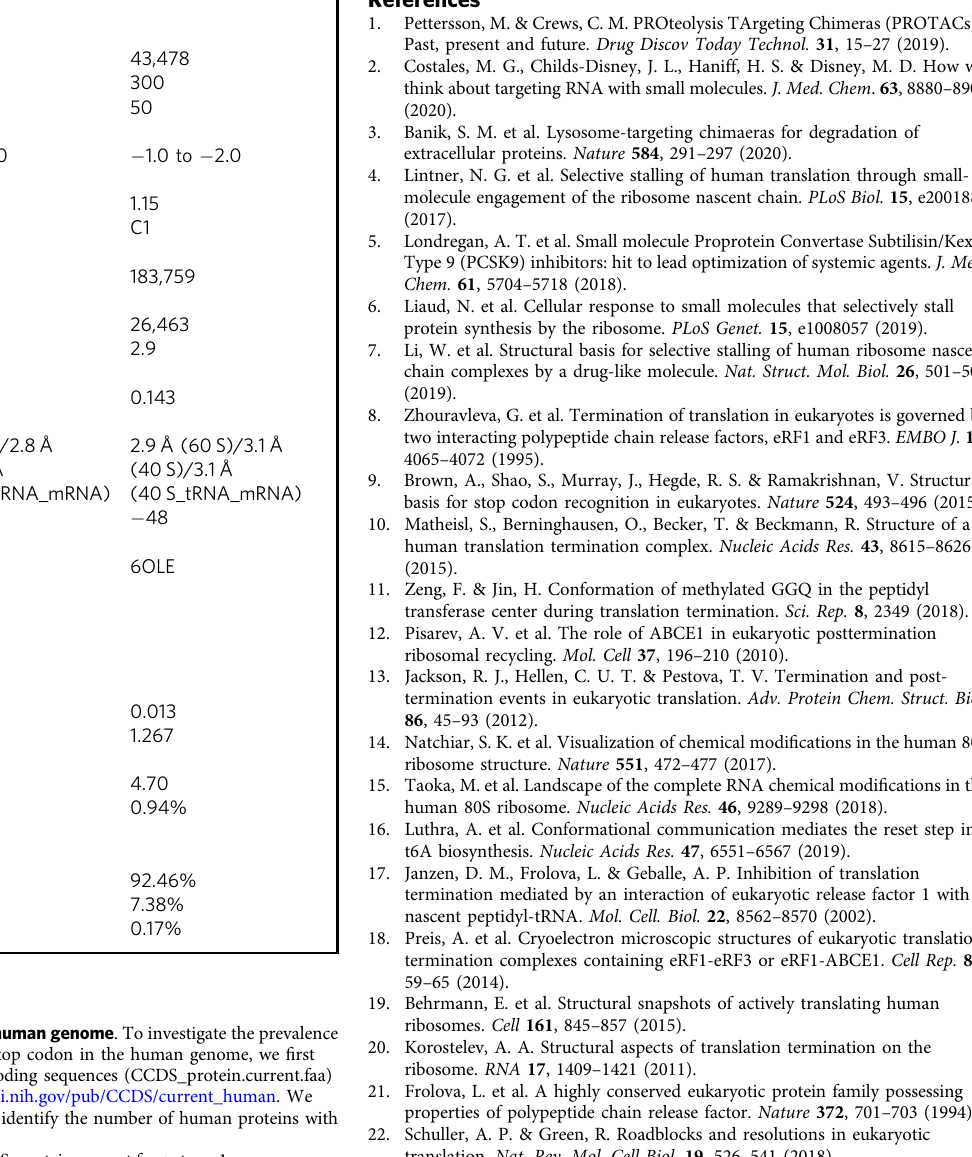
Figure preparation . Figures were prepared using UCSF Chimera 67 , UCSF Chi- meraX 68 , and PyMOL (Schrödinger). Reporting summary . Further information on research design is available in the Nature Research Reporting Summary linked to this article.